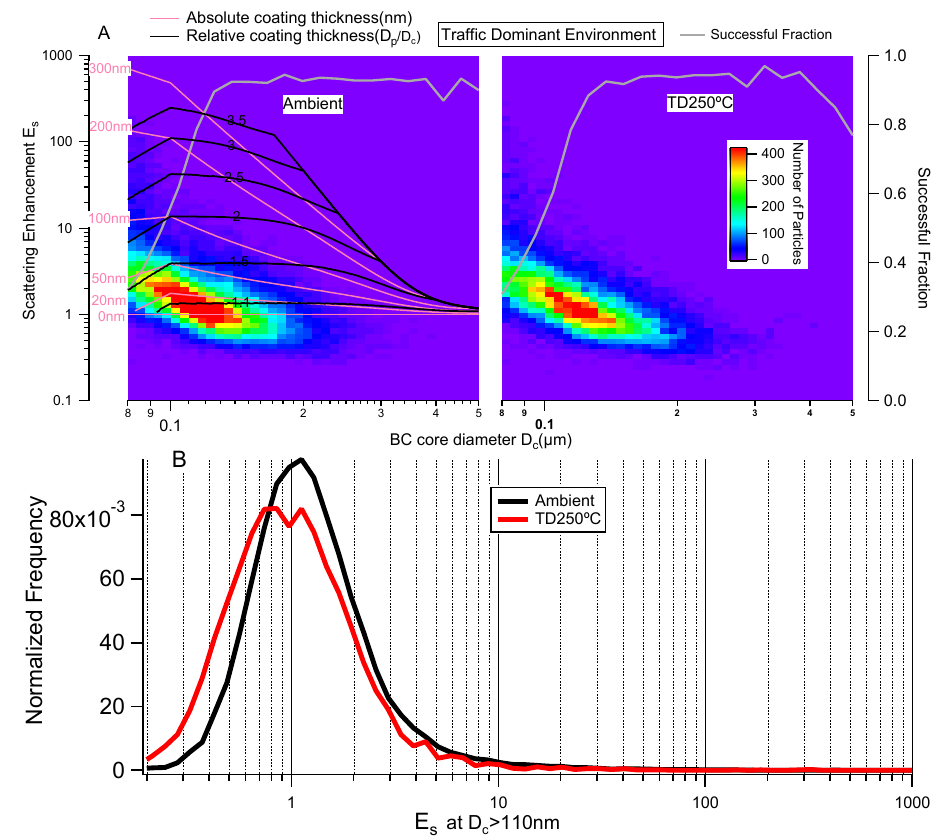
Figure 4. BC optical properties when the environment is dominated by traffic source (22 to 24 January during W air masses). (a) The scattering enhancement ( E s ) as a function of BC core diameter ( D c ) . The image plot is a two dimensional histogram for the detected particles. The solid grey line, with corresponding scale on right axis, shows the number fraction of BC particles that were successfully determined according to their scattering signal at each D c size. The left panel is for the ambient data, whereas the right panel is the same group of BC particles after passing through the thermodenuder (TD) at 250 ◦ C. The thinner red and black contours show the corresponding absolute coating thickness (in nm, ( D p − D c )/ 2) and relative coating thickness ( D p /D c ) , respectively. (b) The area normalised histogram of E s for the particles with D c